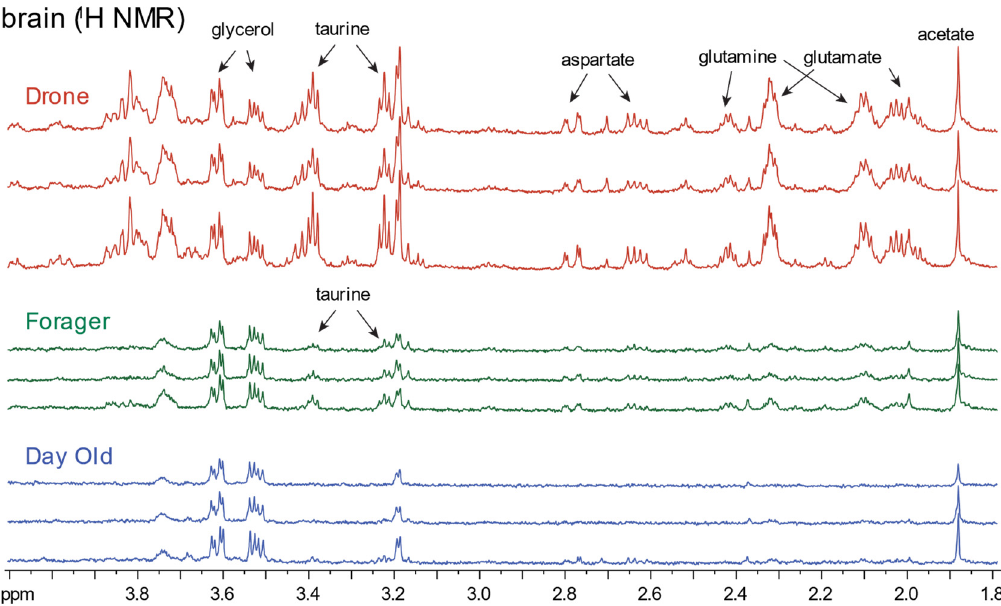
Figure 4. Representative 1 H-NMR spectra (PURGE, 600 MHz, 14.1 T, 25 ◦ C, 128 scans) of the aqueous phases of chloro- form:methanol extractions from homogenized bee brain samples. Spectra show differences between day-old bee (worker), foragers (worker), and drones (males), particularly with respect to number of metabolites corresponding directly with brain size of bees. This series was conducted without a chemical shift standard in order to observe spectra in the absence of confounding signals/standards. Chemical shifts were referenced to a secondary standard.